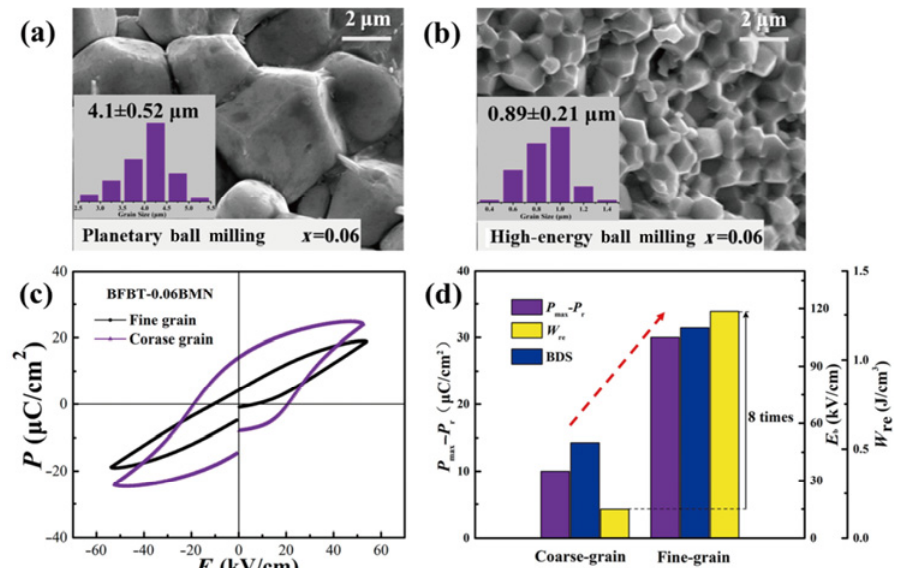
Fig. 17 SEM images of BF–BT–0.06BMN ceramics prepared via (a) planetary ball milling and (b) high-energy ball milling. (c) P – E loops and (d) energy storage performance of BF–BT–0.06BMN ceramics. Reproduced with permission from Ref. [73], © Elsevier Ltd and Techna Group S.r.l. 2021.